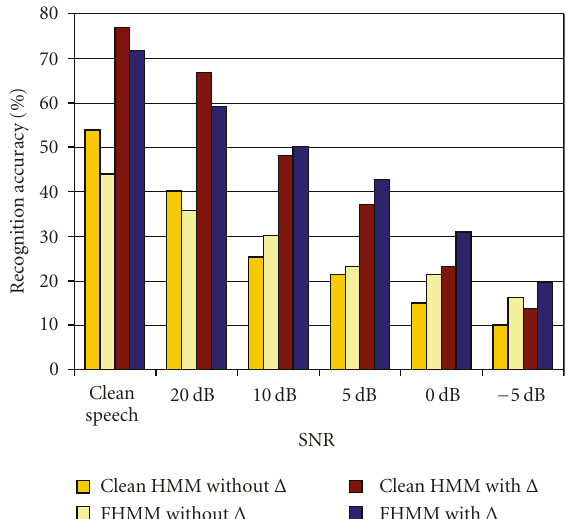
Figure 6: Recognition rates of speech artificially corrupted by sud- den noise. HMMs (baseline) and the proposed method (noisy FH- MMs) with and without Δ features.